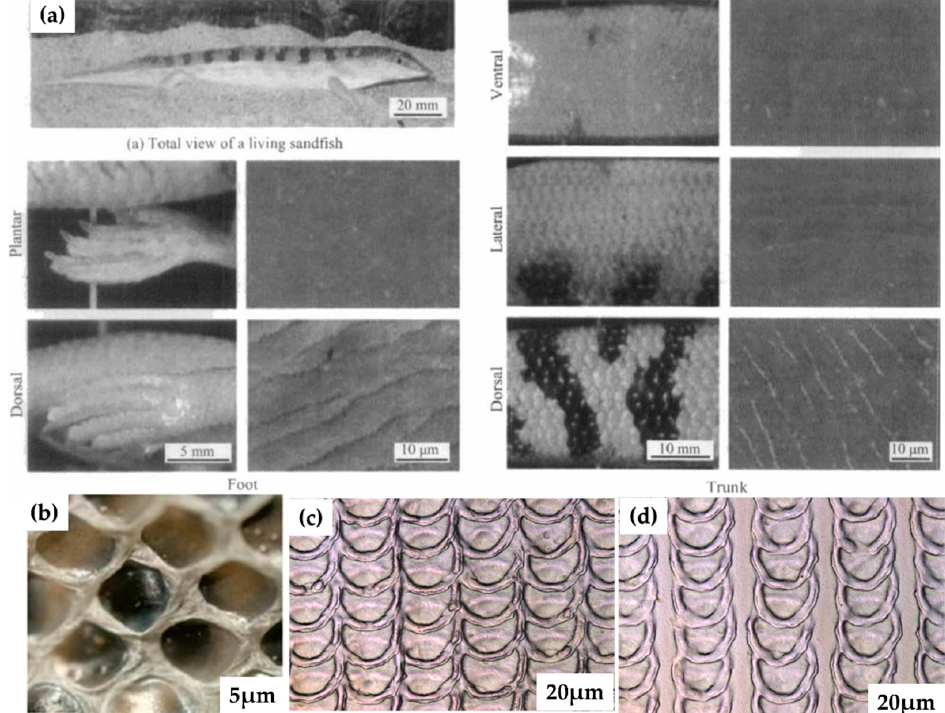
Figure 6. ( a ) Surface morphology of sandfish, ( b ) scales texturing attributed to the ball python, ( c ) vertical and horizontal overlapping of artificial scales over a snake (ball python), ( d ) only horizontal overlapping scales resembling snake skin [53,183]. Copyright permission from IOP, 2015; Copyright permission from Elsevier, 2015.